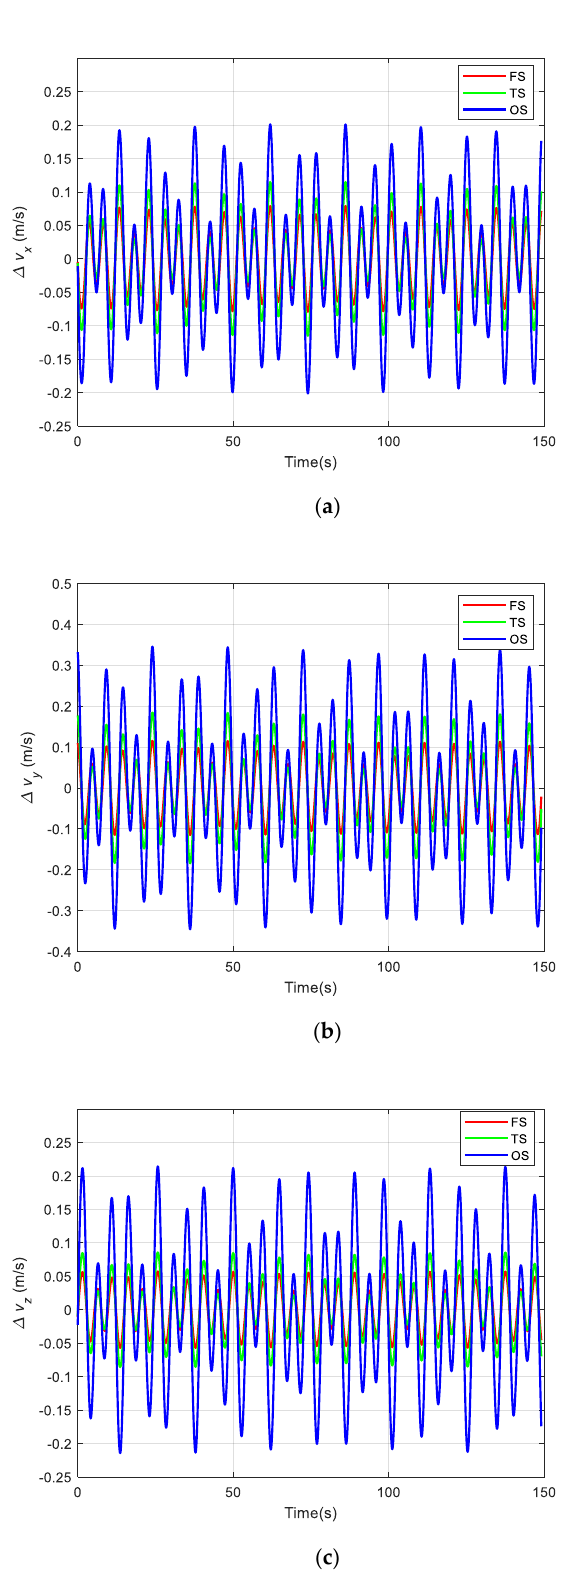
Figure 9. The sculling error curve of SINS with the compensation algorithm of one-subsample(OS), three-subsample(TS), and four-subsample (FS): ( a ) the error curve in X-direction, ( b ) the error curve in Y-direction, ( c ) the error curve in Z-direction.